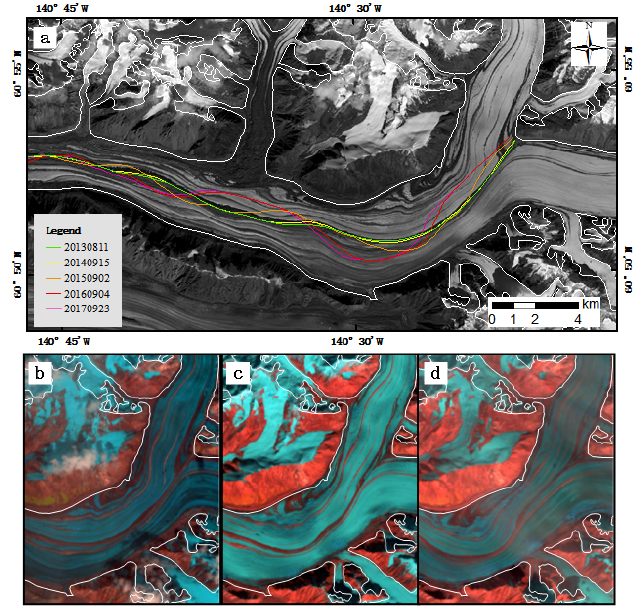
Figure 6. Evolution of the medial moraine associated with the surges. ( a ) Manually delineated medial moraines overlaid on Landsat images (band 8) from 11 August 2013. ( b – d ) Landsat images (bands 6, 5 and 4, combined) from 15 September 2014, 2 September 2015 and 4 September 2016, respectively.